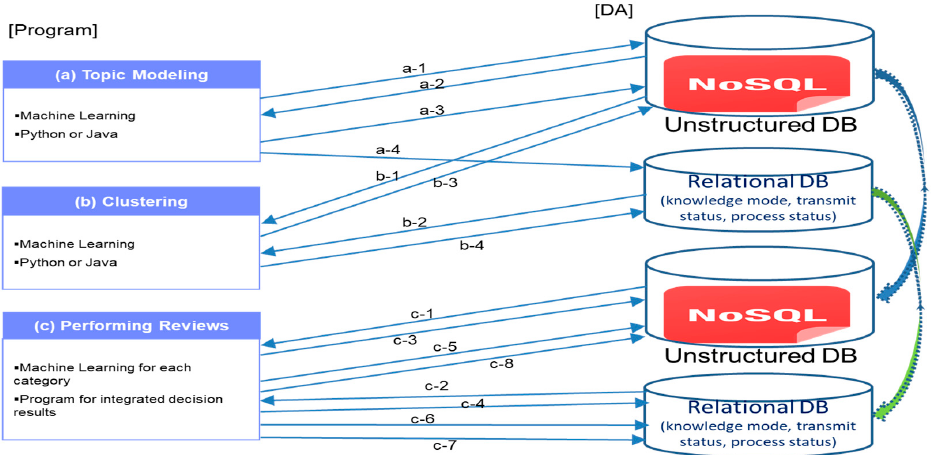
Figure 13. Concept of database access flow for machine learning programs in new drug develop- ment review system. review